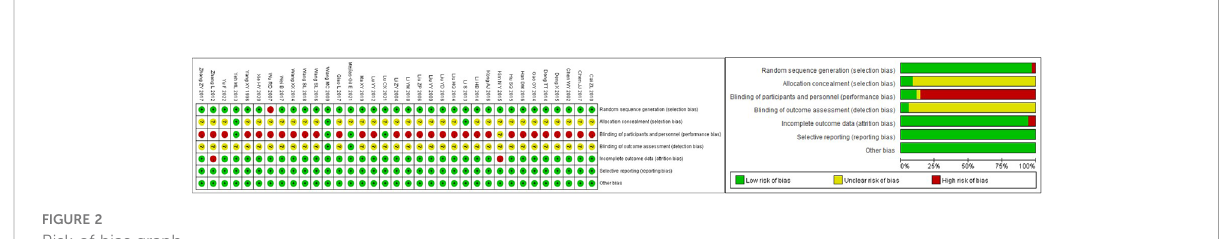
FIGURE 2 Risk of bias graph.